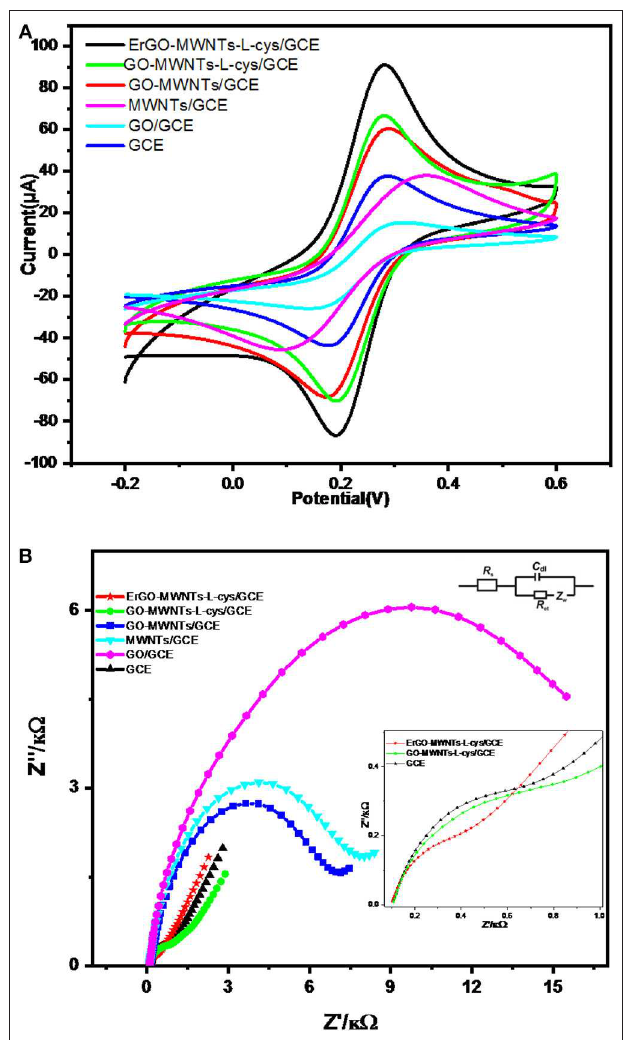
FIGURE 7 | (A) CV and (B) EIS characterizations of bare GCE, GO/GCE, MWCNTs/GCE, GO–MWNTs/GCE, GO–MWNTs–L-cys/GCE, and ErGO-MWNTs-cys/GCE in 0.1M KCl solution containing 5mM [Fe(CN) 6 ] 3 − / 4 − couple as a redox probe system. The parameters of CV and EIS are 0.5 Vs − 1 scan rate repeated in the range between − 0.2 and 0.6V and frequency range from 0.1 to 105Hz while applying 0.2V AC amplitude, respectively. Inset: magnification plot of higher frequencies and equivalent electrical circuit used for fitting the impedance